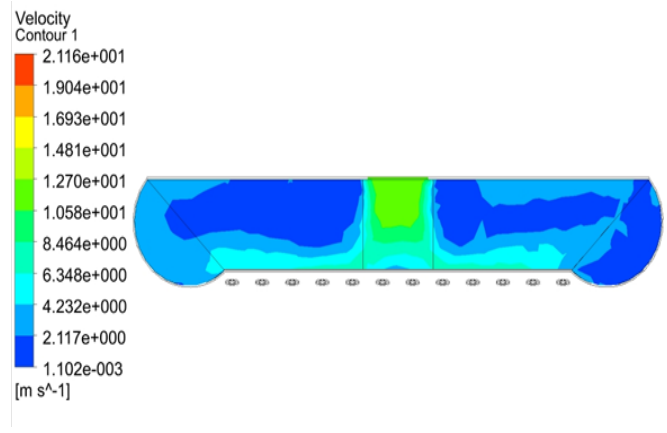
Figure 7. Velocity contour at YZ plane of